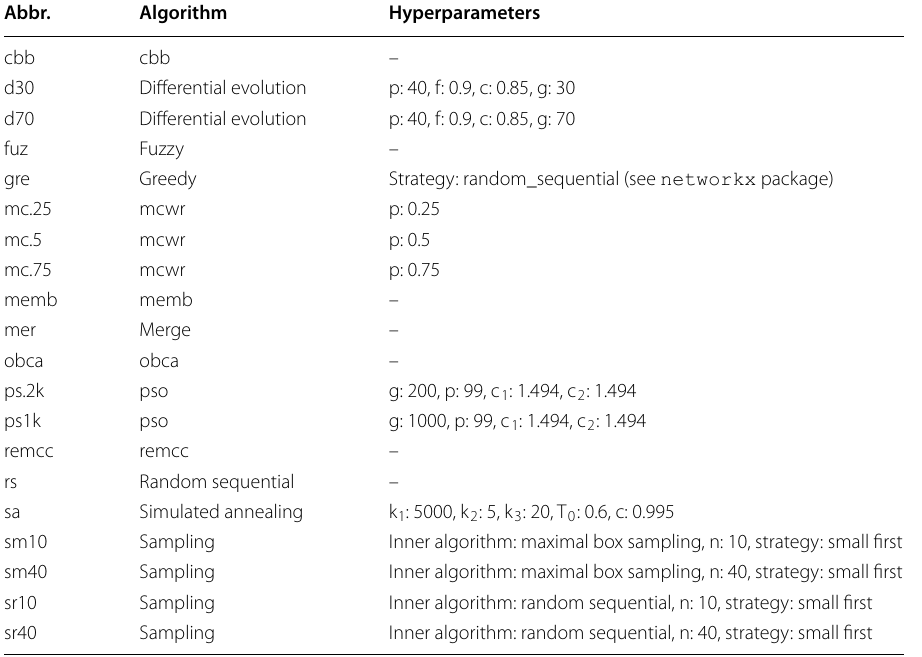
The leftmost column stands for the abbreviation. In some plots, the expanded version of these abbreviations appears but it is clear what they mean